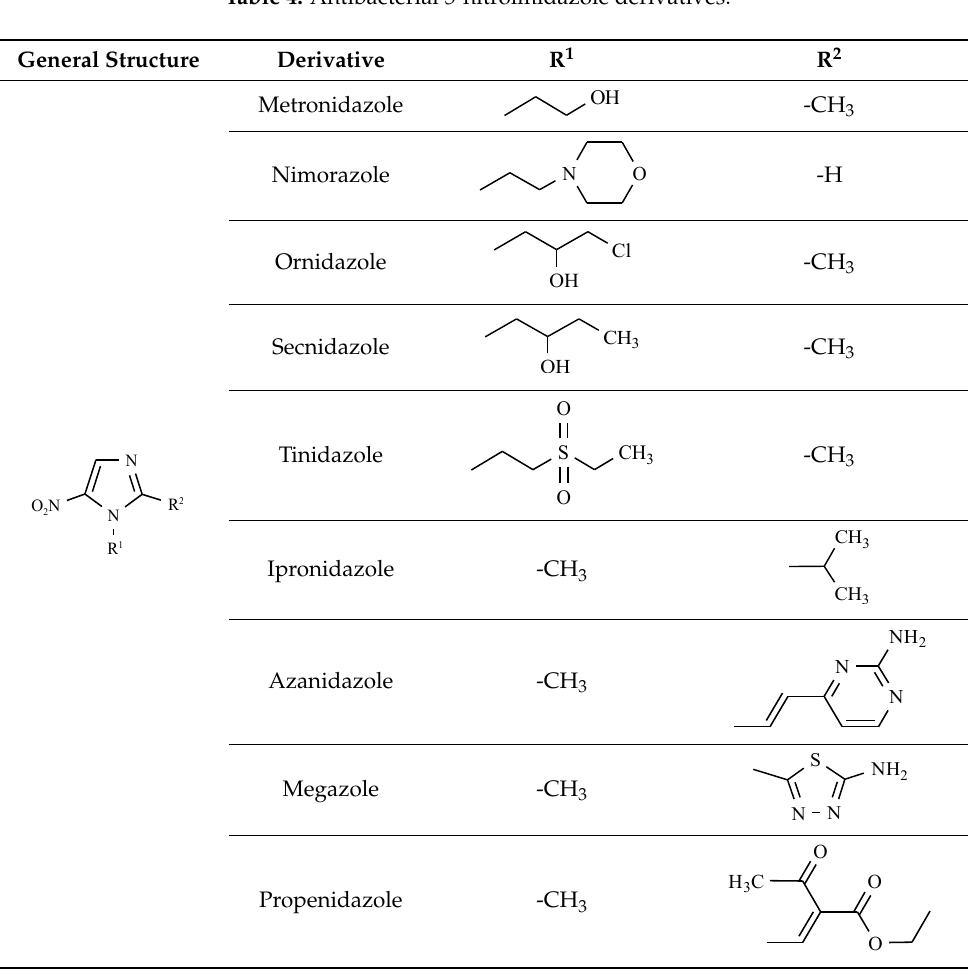
R 2 Figure 9. Structure-activity relationships of 2-nitroimidazoles [34]. Derivatives of 5-nitroimidazole (azanidazole, ipronidazole, metronidazole, tinidazole, nimorazole, ornidazole, and many others) (Table 4) and 5-nitrothiazole (e.g., niridazole and nitazoxanide) have two-way activity [35]. This strictly concerns anaerobic bacteria and protozoa. In